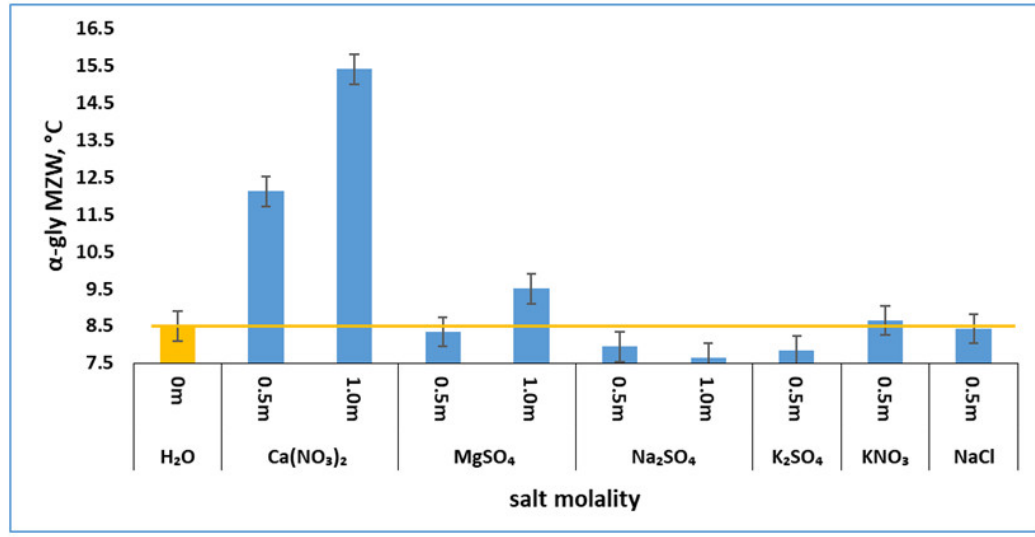
Figure 2. Impacts of four inorganic salts on the metastable zone widths (MZWs) of α -glycine primary nucleation (error bar = ±0.4 °C).